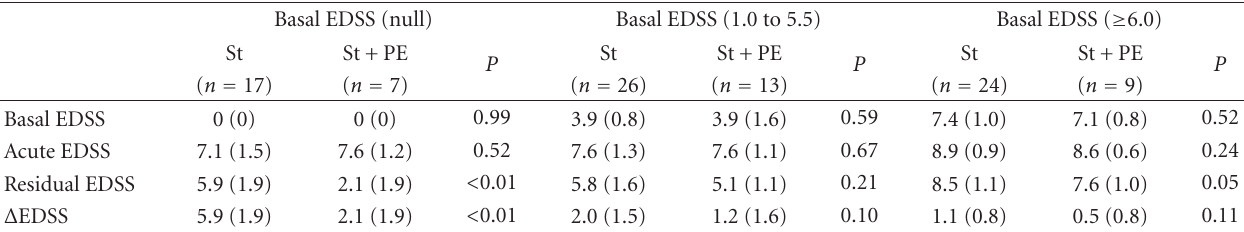
Table 1: Disability measured as EDSS during spinal attacks stratified with basal impairment. St: steroid-only-treated group; St+PE: steroid- and PE-treated group. Values are given as mean (SD) (from [37]).